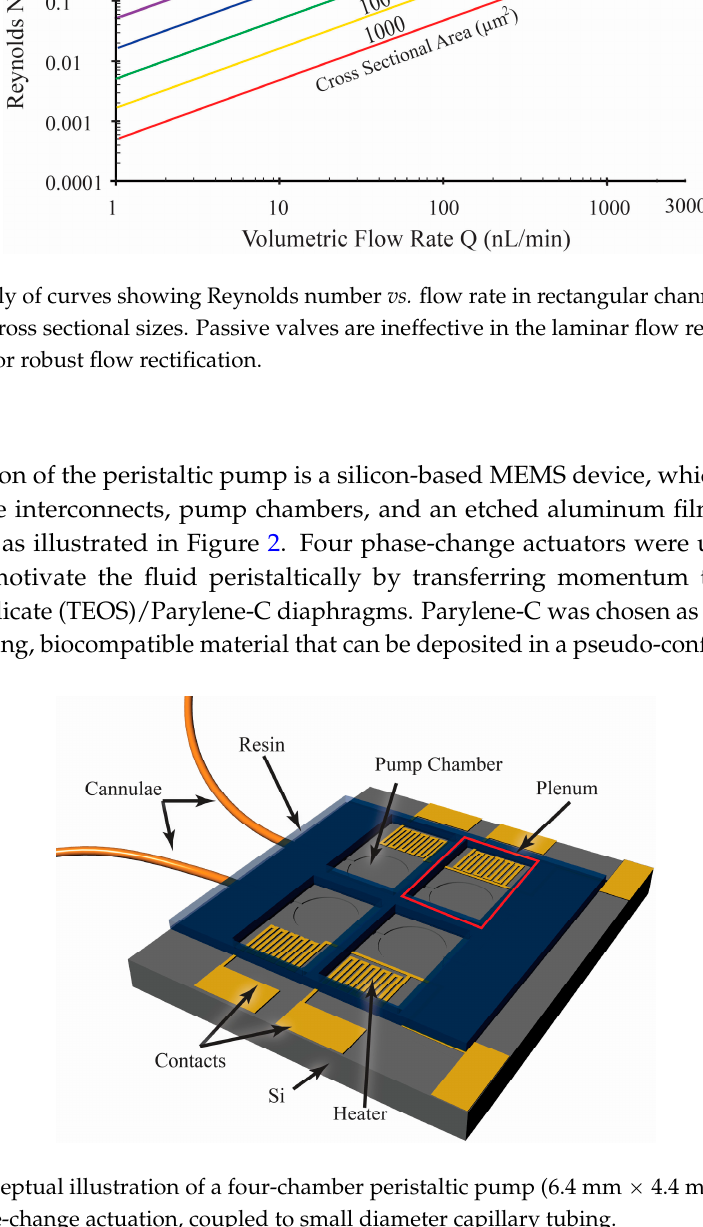
Figure 2. Conceptual illustration of a four-chamber peristaltic pump (6.4 mm × 4.4 mm × 1 mm)